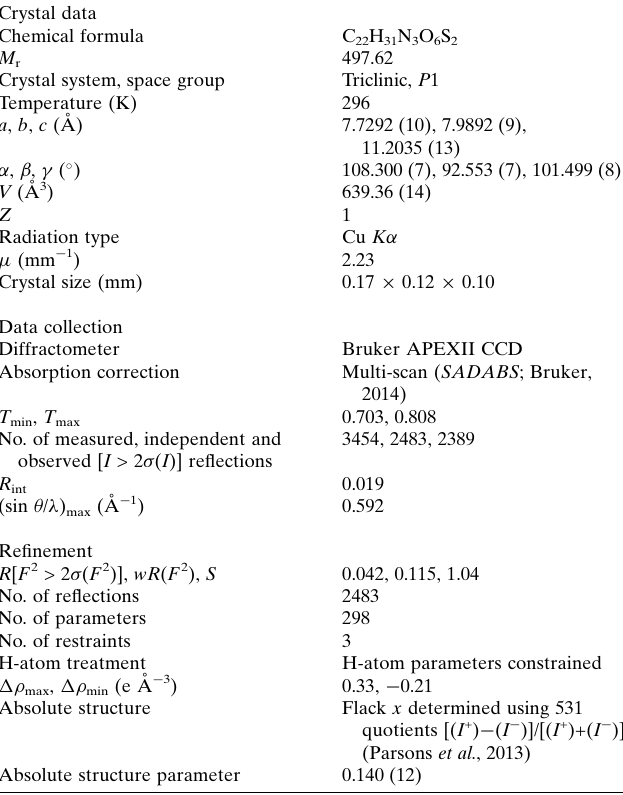
Table 2 Experimental details. Crystal data Chemical